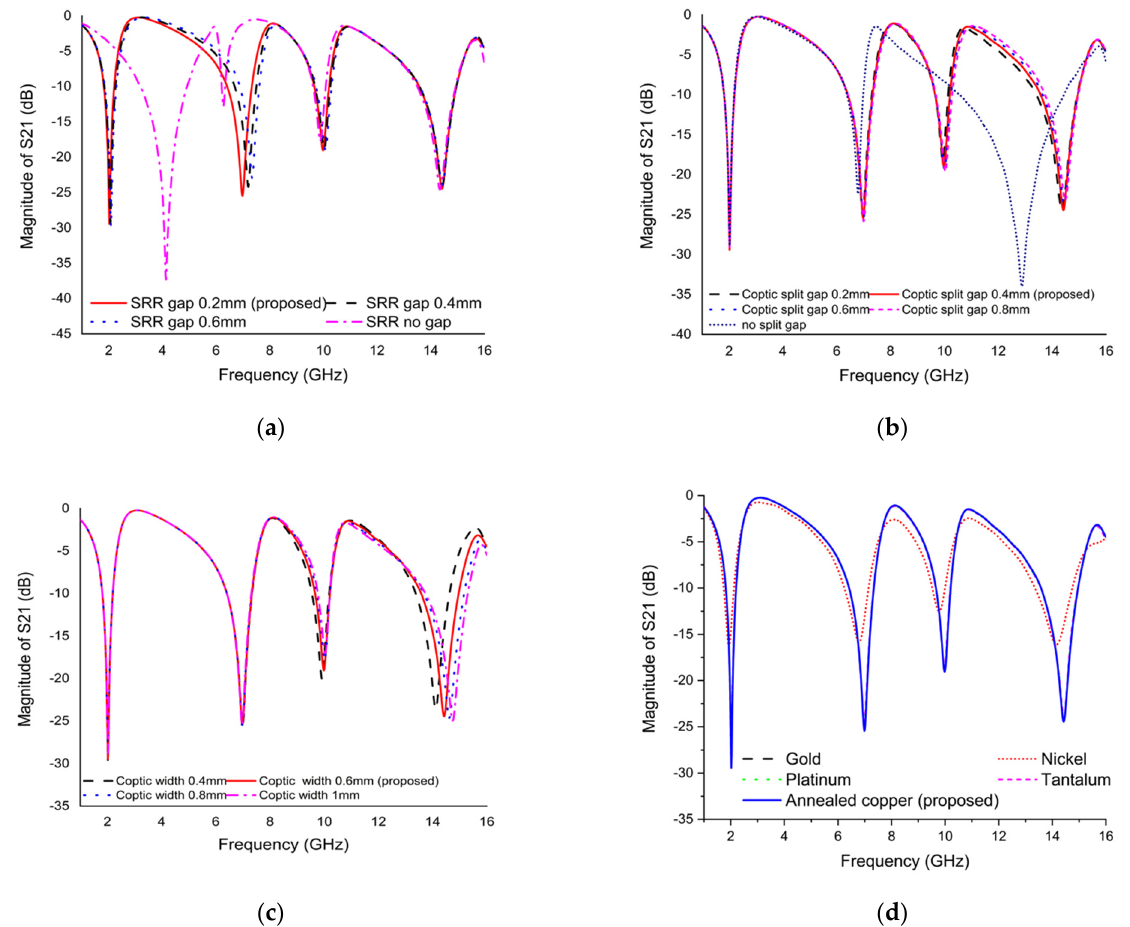
Figure 5. The S 21 plot for ( a ) changing of split gap of SRR, ( b ) changing of split gap of Coptic cross resonator, ( c ) varying the width of the Coptic cross resonator, and ( d ) effect of different conductors used in resonator.